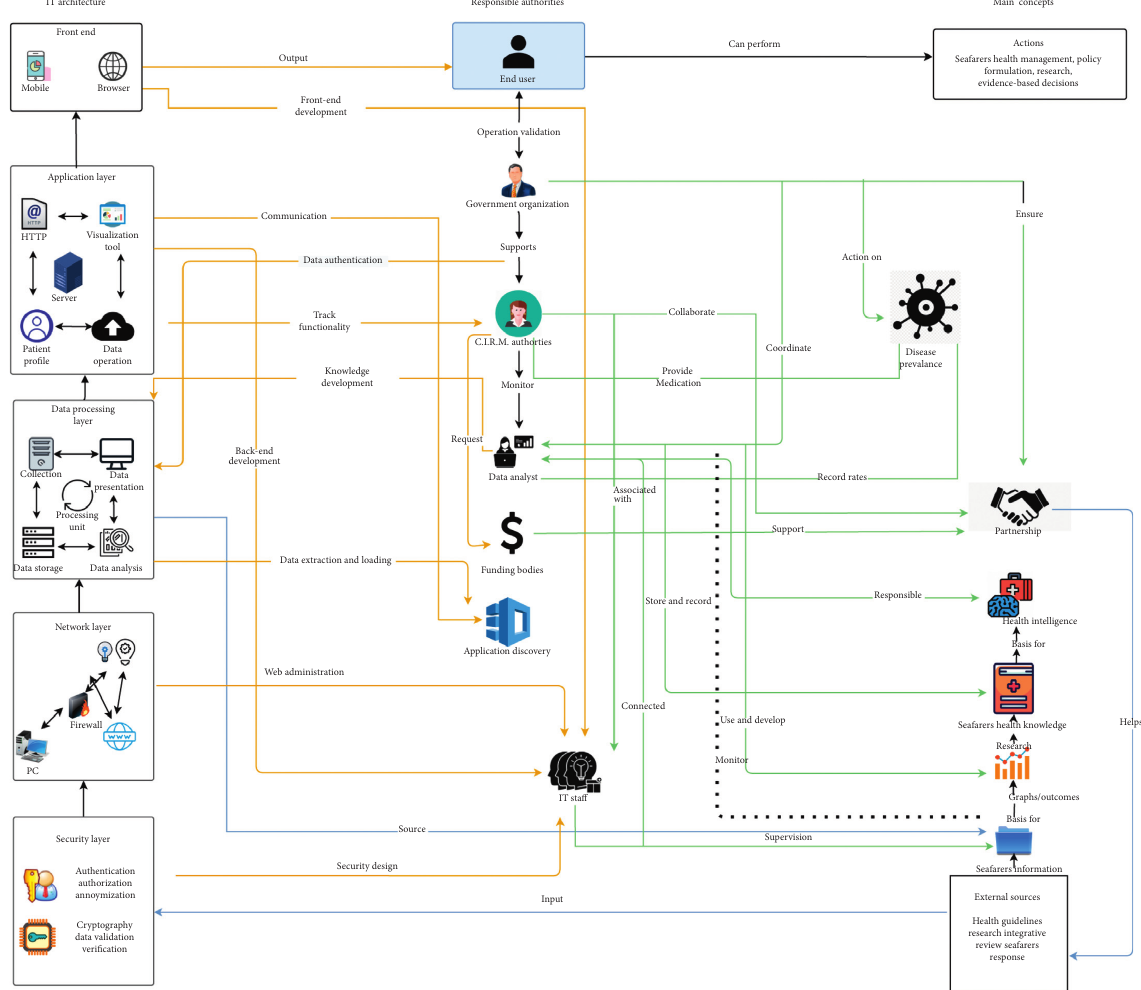
Figure 1: Conceptual framework of seafarers’ HO